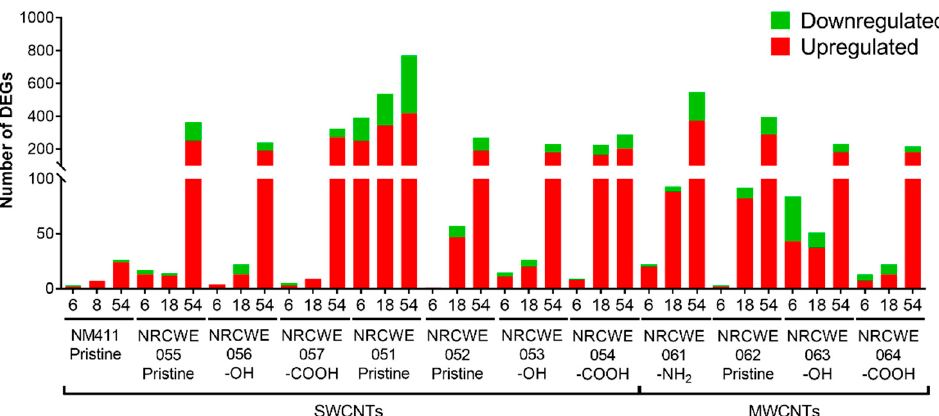
Figure 3. Number of DEGs at 6, 18, and 54 µ g/mouse after 1 day of exposure to CNTs. DEGs were defined as genes with an FDR p -value ≤ 0.05 and a fold change of ± 1.5 in either direction. Red: upregulated. Green: downregulated.